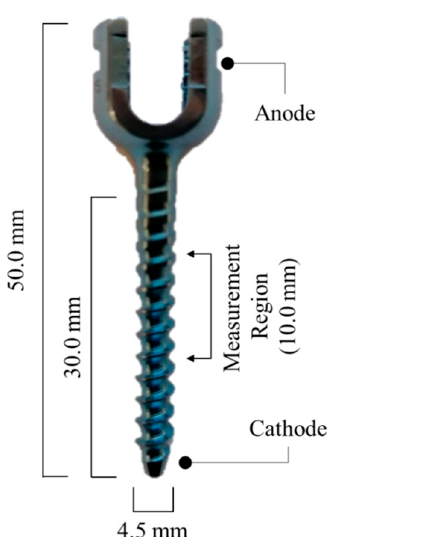
Figure 1. Representation of the ( a ) Spinelock and ( b ) Spinecall pedicle screws specimens used in this study, their physical dimensions and relevant current application and measuring points.